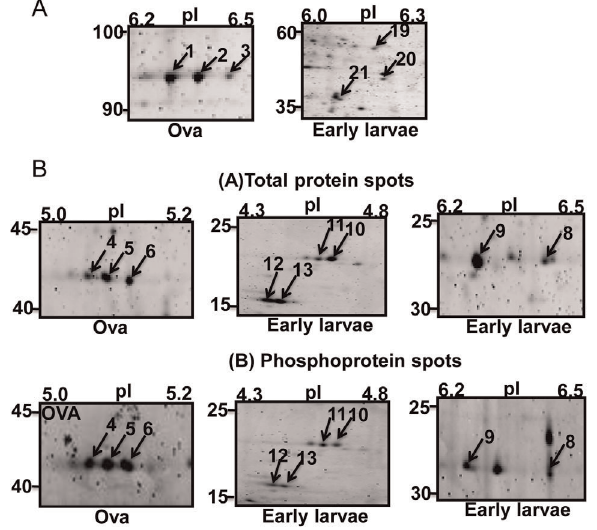
Figure 2. Representative proteome and phosphoproteome 2- DE gel images of fertilized ova, and two larval stages of Neanthesarenaceodentata .